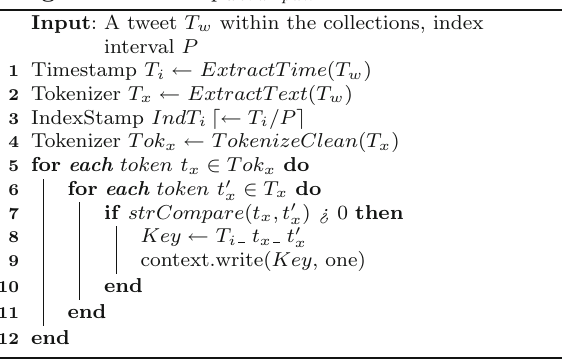
Algorithm 1: Map word −